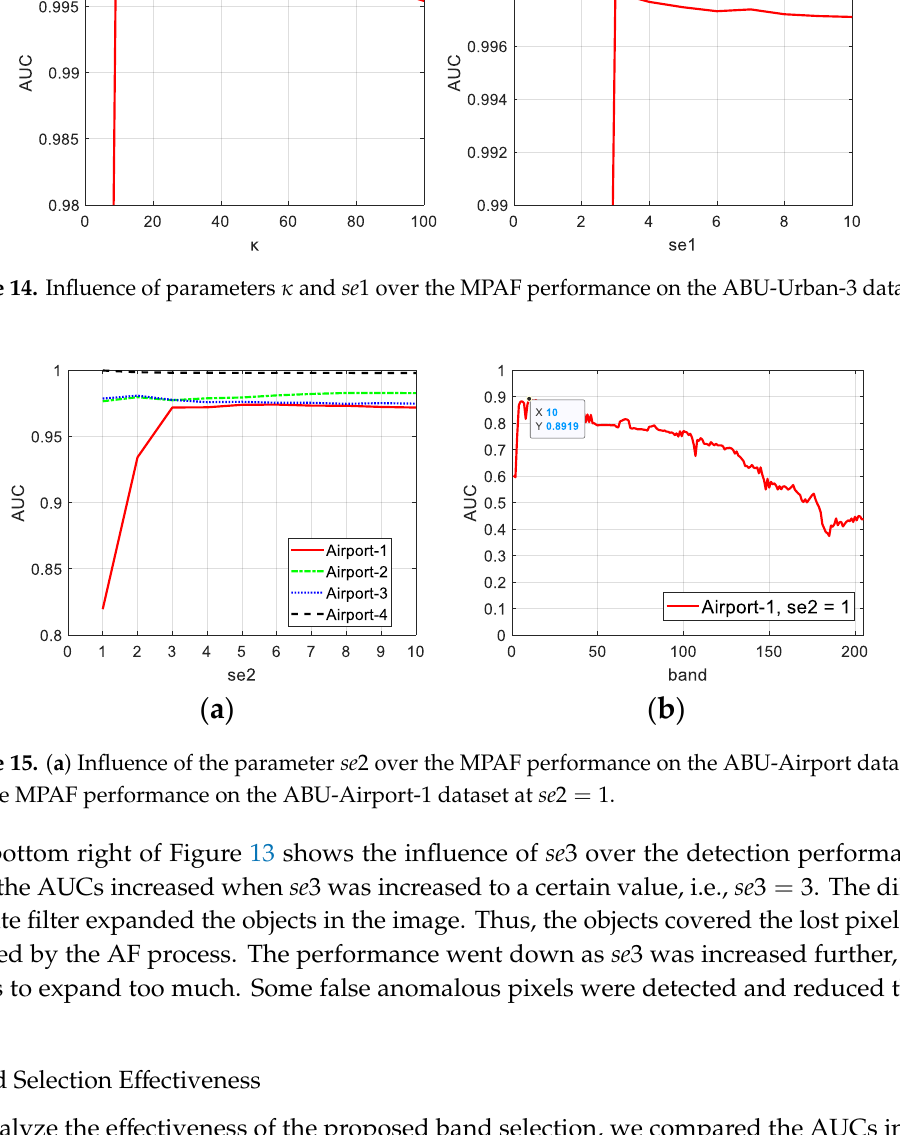
Table 5. Comparison between AUC of the MPAF’s best band and AUC of the MPAF’s selected band on the ABU datasets.